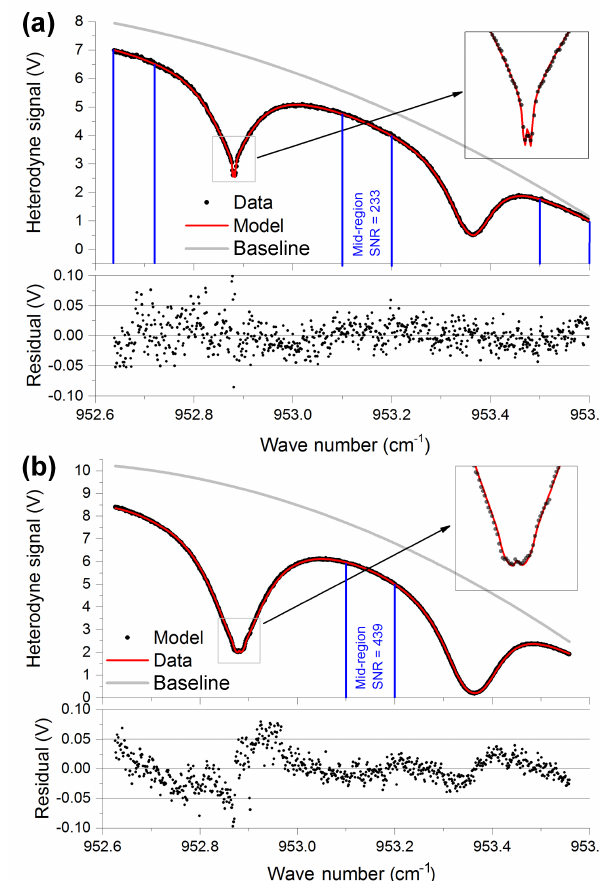
Figure 6. Atmospheric spectra (and modelled fits after retrieval) in the selected window at two spectral resolutions, recorded (a) on 10 September 2015 11:17UTC at 60MHz with a midsection SNR of 233 and (b) on 28 September 2015 15:29UTC at 600MHz with a midsection SNR of 439. The thin blue lines delimit the spectral window over which the SNR and measurement noise are estimated after applying a second order polynomial fit. The thin grey lines show the polynomial baselines due to LO power